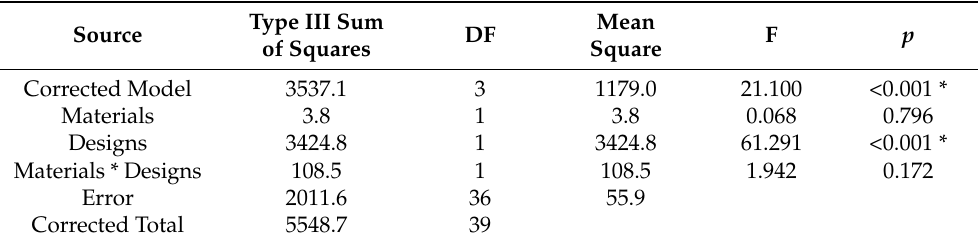
Figure 7. Graphical representation of mean marginal fit ( µ m) according to the two studied materials and preparation design. Table 3. Two-way ANOVA used to compare marginal fit ( µ m) between the studied materials and preparation designs.